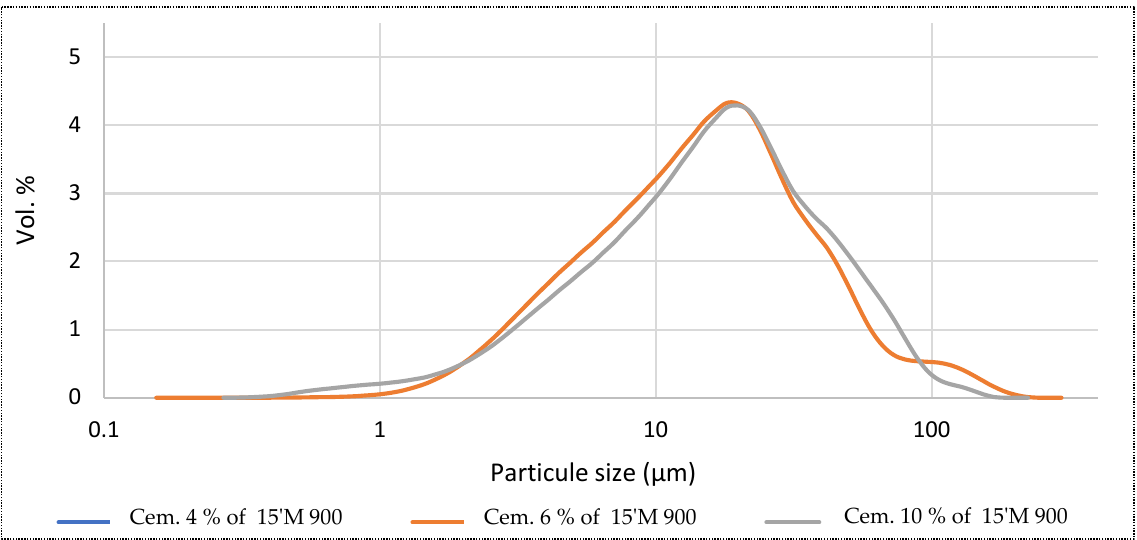
Figure 10 . Particle size distribution of CEM produced by indirect mechanosynthesis. Figure 10. Particle size distribution of CEM produced by indirect mechanosynthesis. The third range is found between 5.8 mm and 31.5 mm, with a maximum peak at The PSDs analysis shows that the cement produced with 4% 𝐶𝑆 has a multi-modal 19.6 mm. The fourth range is found between 31.5 mm and 60.52 mm, with a maximum distribution, where the first range is found between 0.27 mm and 1.45 mm with a maxi- peak at 41.61 mm. Finally, the last range is located between 60.52 mm and 105.93 mm, with mum peak at 0.68 mm and the second range is located between 2.1 mm to 5.8 mm with a a maximum peak at 80.074 mm. maximum peak at 2.3 mm.